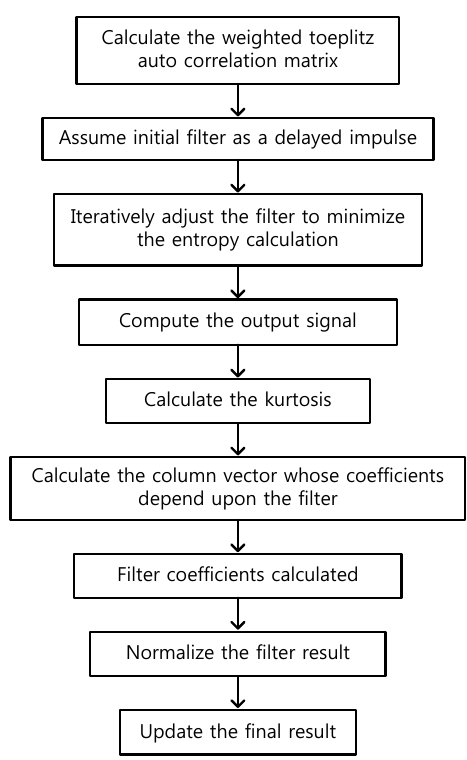
Figure 1. A systematic block diagram to illustrate the process of minimum entropy deconvolution